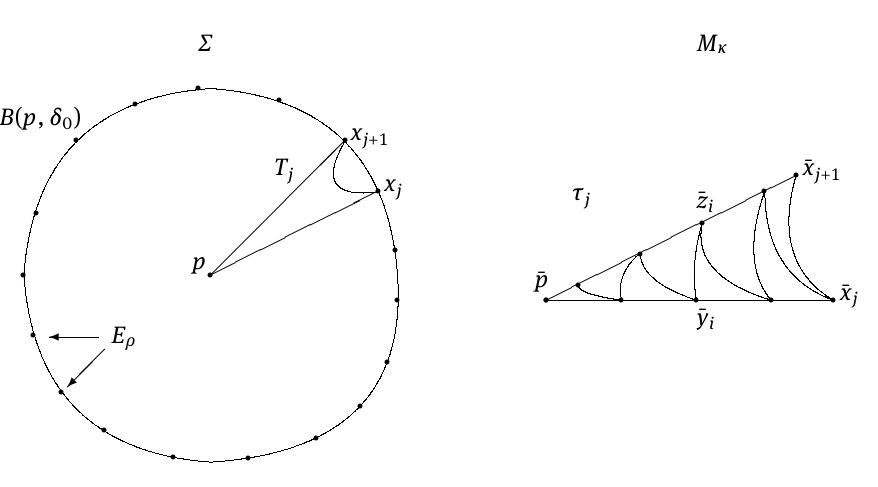
Figure 3: Comparison triangles for the upper